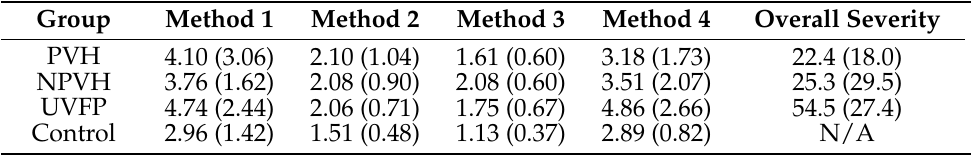
Table 4. Error of the four subglottal pressure (Ps) estimation methods for each patient group and vocally typical group in terms of root-mean-square error (units of cm H 2 O) with respect to reference Ps values obtained using the indirect intraoral equilibration method. The mean and standard deviation (SD) of the error are listed. Reported also for the patient groups are the mean (SD) of the auditory- perceptual rating of overall severity (higher values on the 0–100 scale indicate higher dysphonia).